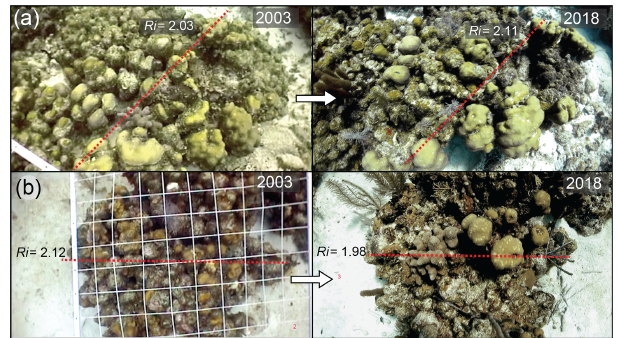
Figure 4. (a–b) Paired photographs of Orbicella. annularis colonies from 2003 (5 years post-disturbance) and 2018 (20 years post-disturbance) and the structural complexity ( R ) derived from model simulations, showing the growth (vertical extension) of sur- viving ramets above the colony and the erosion of dead ramets in